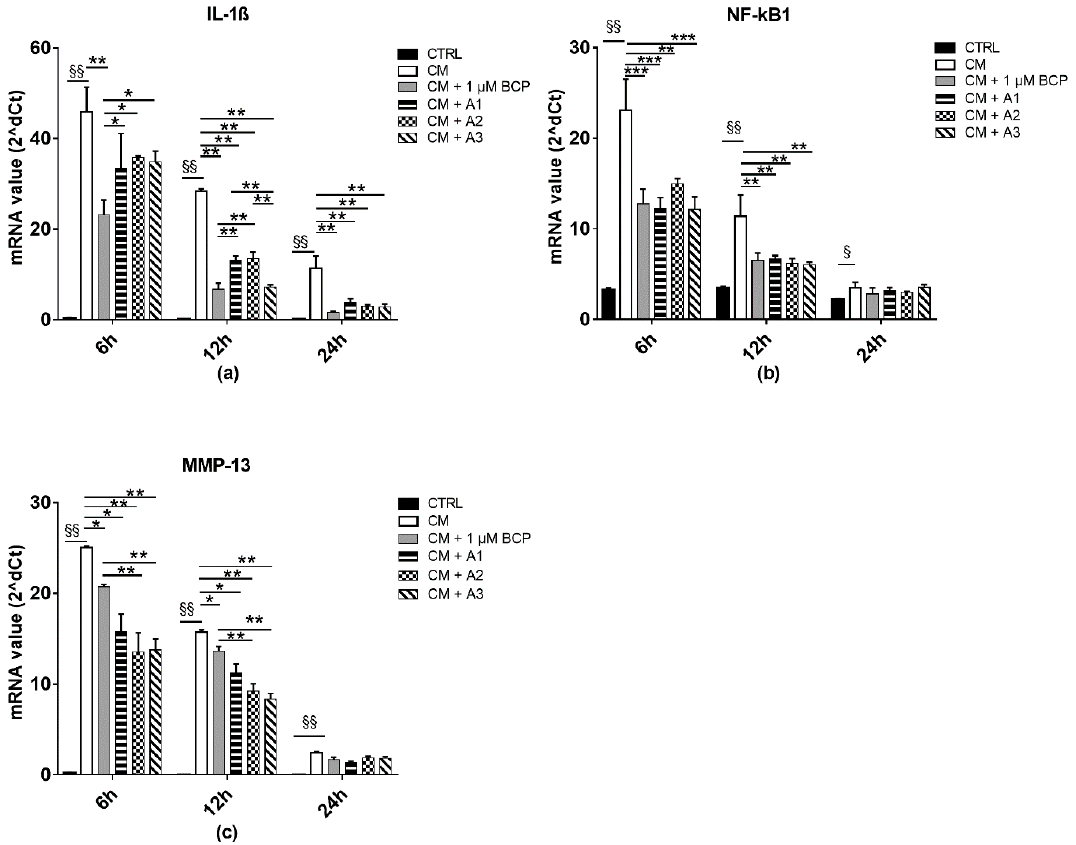
Figure 3. Chondrocyte expression of proinflammatory molecules and MMP-13 after exposure to U937 CM, in the presence or absence of BCP, AA and GlcN. Human chondrocytes were exposed for 24 h to CM of activated U937 and then cultured in the presence or absence of 1 µ M BCP, alone or in combination with different amounts of AA and GlcN (A1, A2, A3 mixtures). RNA transcript levels specific for ( a ) IL-1 β , ( b ) NF- κ B-1 and ( c ) MMP-13 were evaluated by qPCR at 6, 12 and 24 h after treatment. Statistical differences are based on one-way ANOVA test, and data are expressed as mean ± SE obtained from three independent experiments. CTRL, untreated cells; CM, chondrocytes cultures exposed to U937 CM. * p < 0.05 and ** p < 0.01; *** p < 0.001 compared with CM treated control; § p < 0.05 and §§ p < 0.0001, CM-treated cells vs. untreated cells.